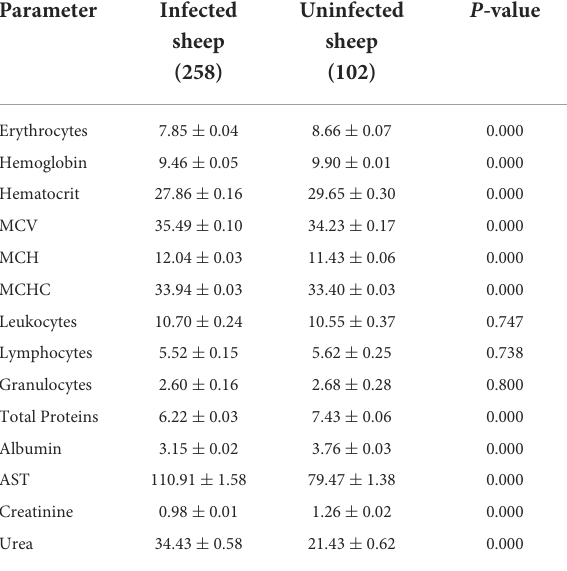
TABLE 2 Hematological and biochemical parameters of infected and uninfected sheep with Theileria spp. Parameter Infected sheep